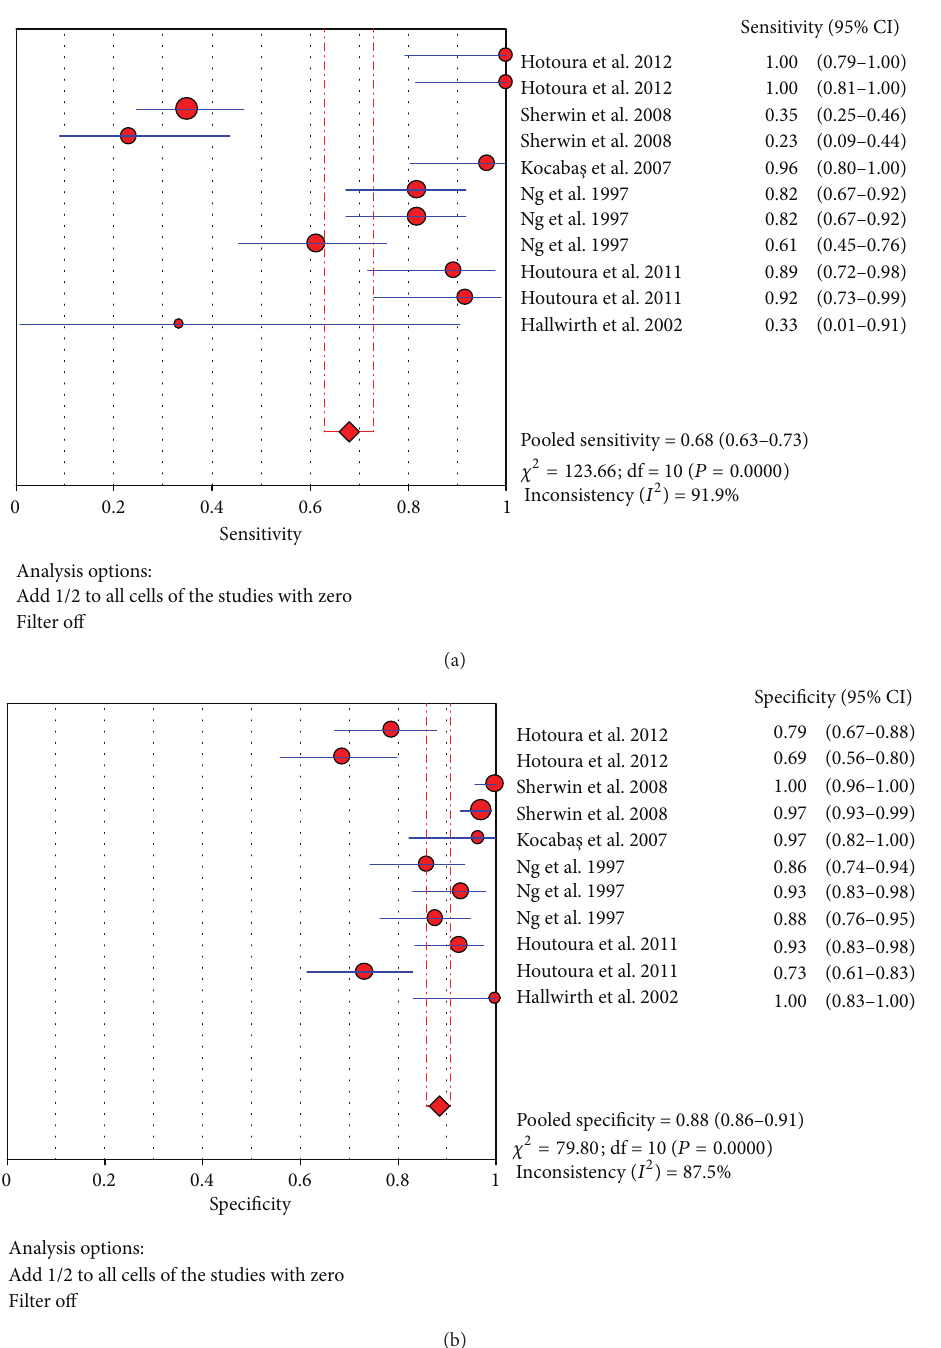
Figure 5: Forest plot for sensitivity and specificity of the TNF- 𝛼 test to diagnose neonatal sepsis at the LONS.